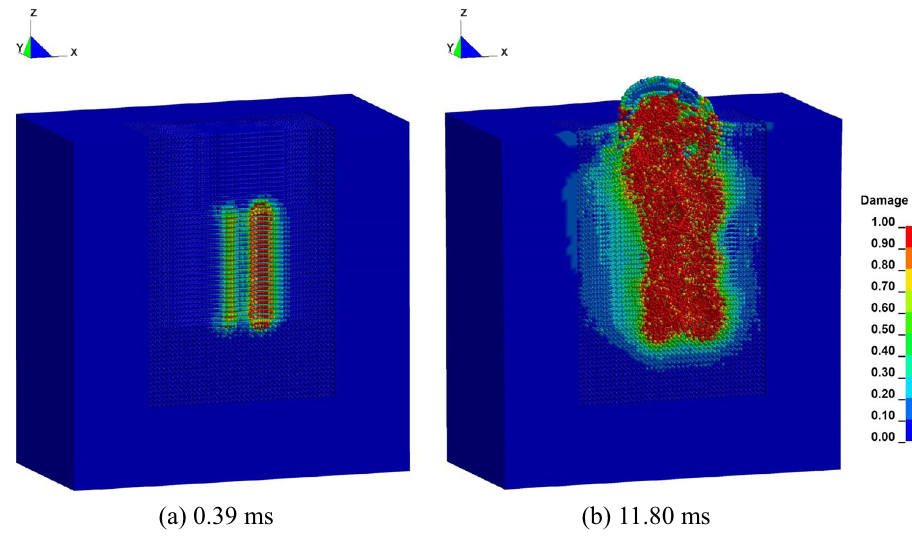
Fig. 12 Continuous charge cut blasting process. a 0.39 ms; b 11.80